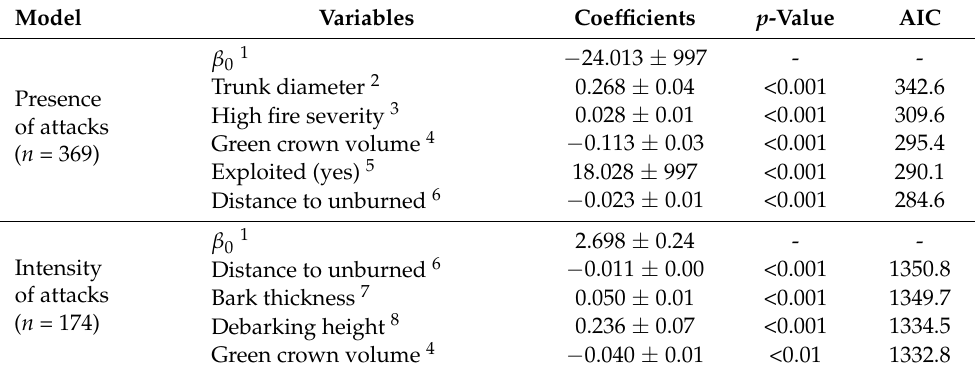
Table 3. Generalized linear models (GLM) showing the variables influencing the presence and intensity of ambrosia beetle attacks in burned cork oaks in the first winter following fire (variables are ordered by decreasing order of importance; models based on 369 and 174 trees,